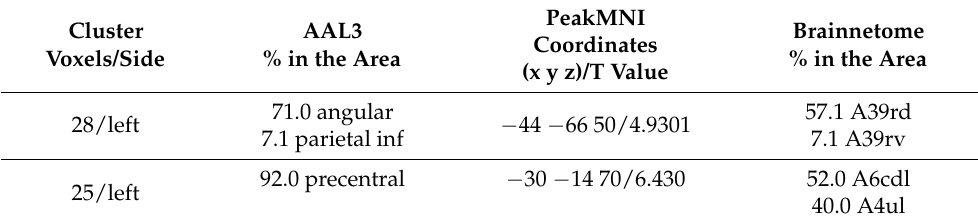
Table 3. Activated areas highlighted by “SLB > SSA” contrast. The number of voxels is given for each cluster, together with the side (i.e., left or right hemisphere), the cluster composition (i.e., the percentage of voxels in each area assigned using AAL3 and brainnetome atlas), MNI coordinates and t value of the peak. Only activated areas covering more than 10% of the cluster are